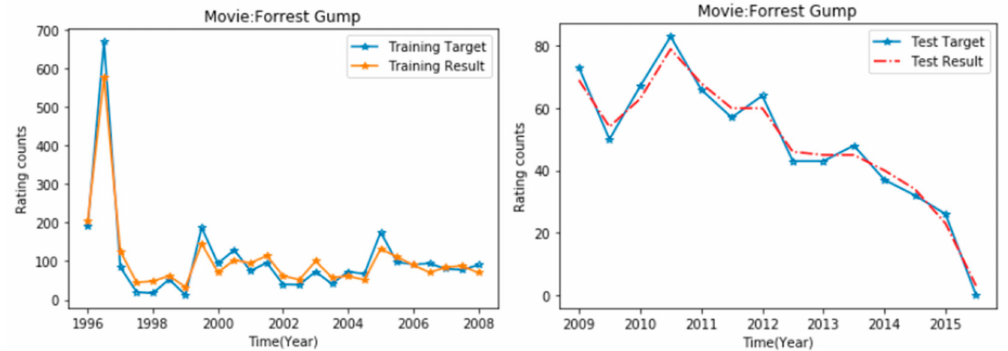
Figure 8. Time series prediction of ML-20M data set popularity: left: training results; right: test results.